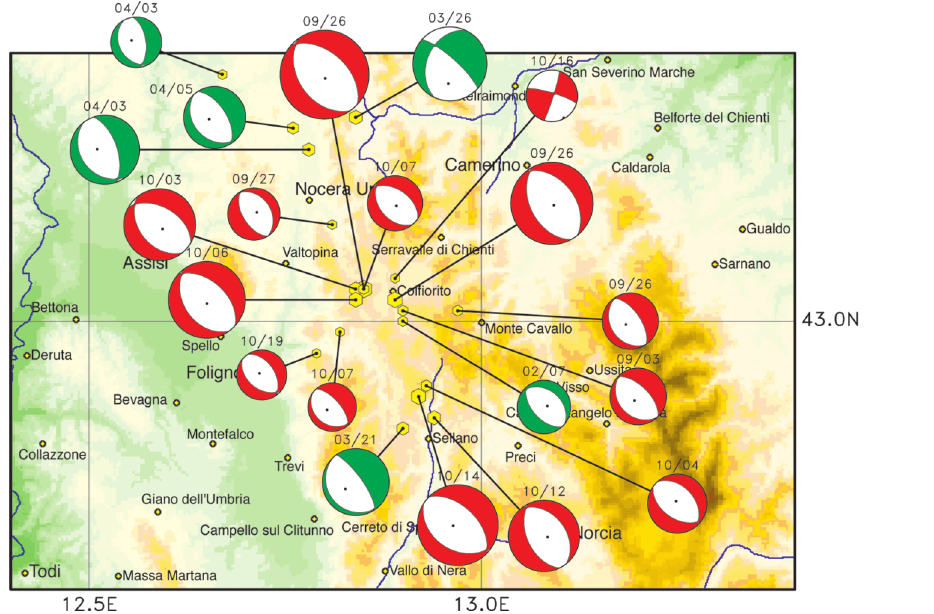
Fig. 4. Map showing the RCMTs computed for the Umbria-Marche seismic sequence. Red: RCMTs for events occurred during September-December 1997; green: those occurred in 1998 (after Morelli et al. ,